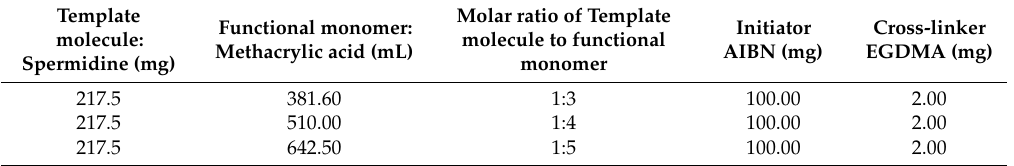
Table 1. Proportion of molecularly imprinted polymer (MIP) synthetic material. Template